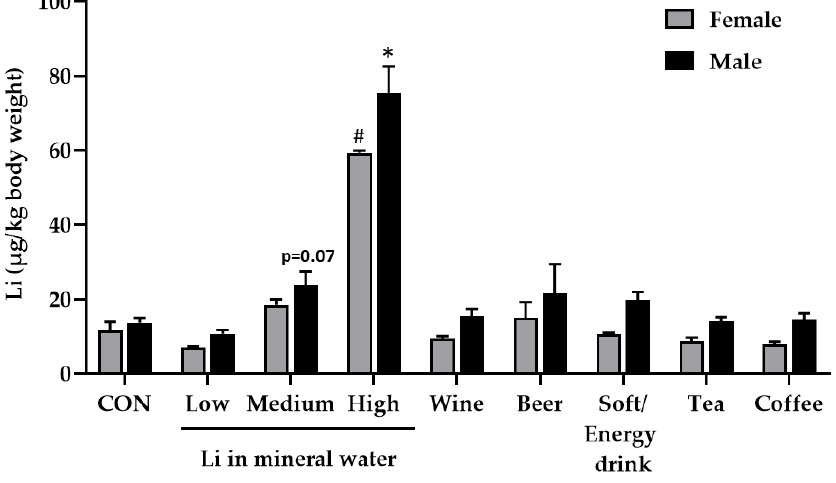
Figure 2. Effect of diets prepared with different beverages on lithium (Li) accumulation in fly bodies. The flies received a sugar yeast diet prepared with deionised water (CON) and eight beverages, including three different mineral waters comprising low, medium and high Li concentrations as well as wine, beer, soft/energy drink, tea and coffee. The Li accumulation in female and male flies was measured by inductively coupled plasma mass spectrometry (ICP-MS). Data are shown as the means ± SEM ( n = 4–8 independent experiments per group, comprising 100 flies/group). Since the data of both sexes were positively skewed, they were inversely transformed, and a Games–Howell post hoc test was conducted. * Indicates significant differences compared to the control in males ( p < 0.05); # Indicates significant differences compared to the control in females ( p ≤ 0.05).